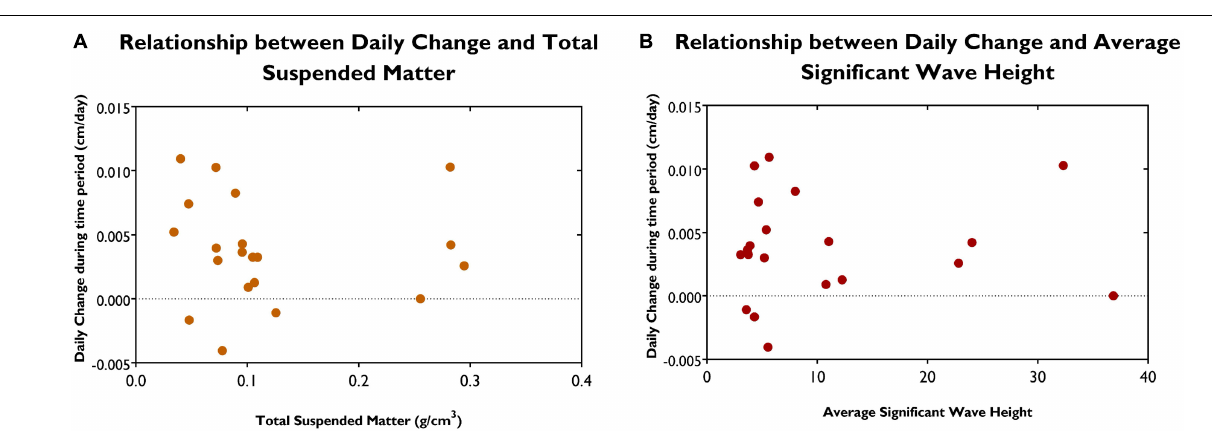
FIGURE 5 | (A) Relationship between daily change between measurement periods and total suspended matter at the various sites. (B) Relationship between daily change between measurement periods and average significant wave height at the various